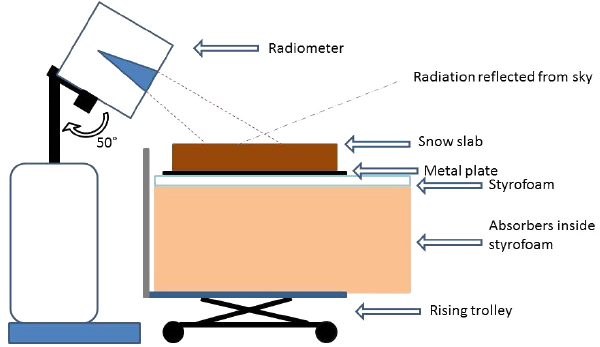
Figure 1. Snow sample was taken from snowpack with a plastic frame, a metal plate and a saw, and a metal bottom plate surrounded by a plastic sheet.